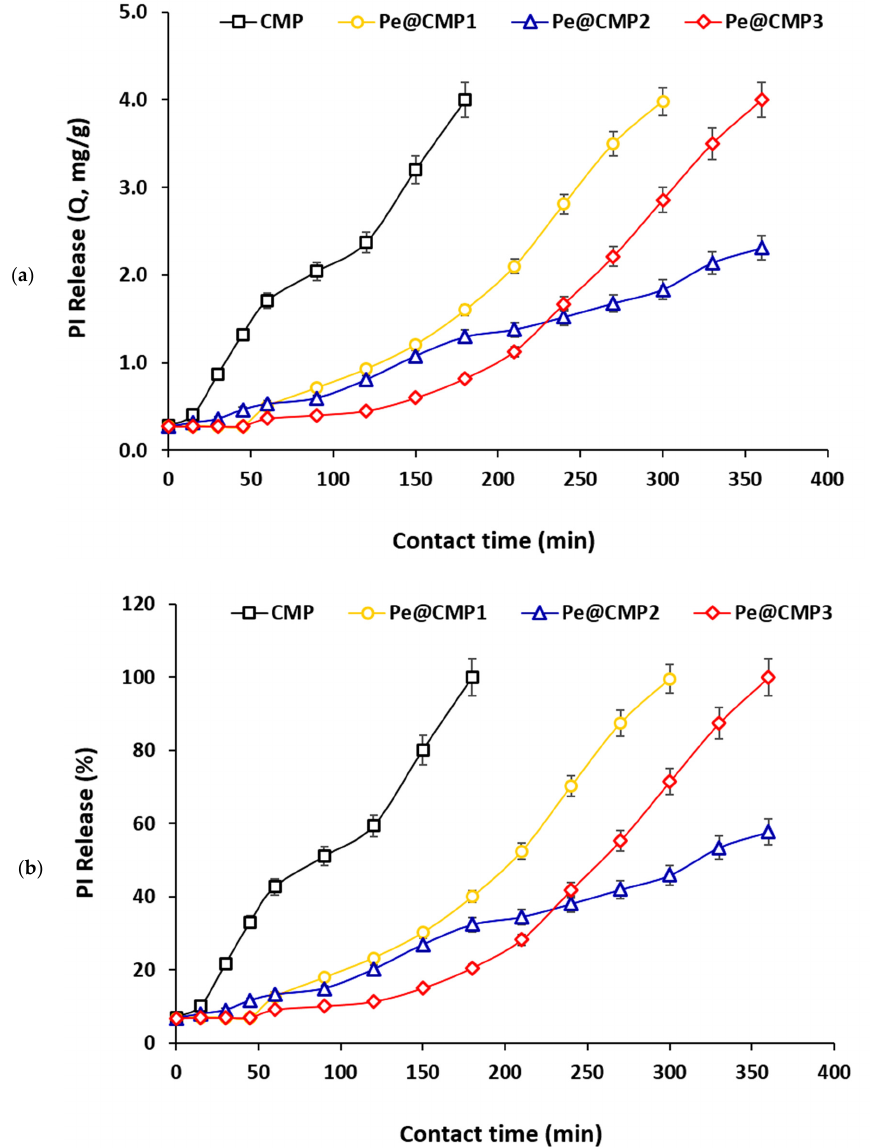
Figure 7. Release behavior of PI in artificial sweat from CMP and Pe@CMP hydrogel; ( a ) release amount and ( b ) release percentage.